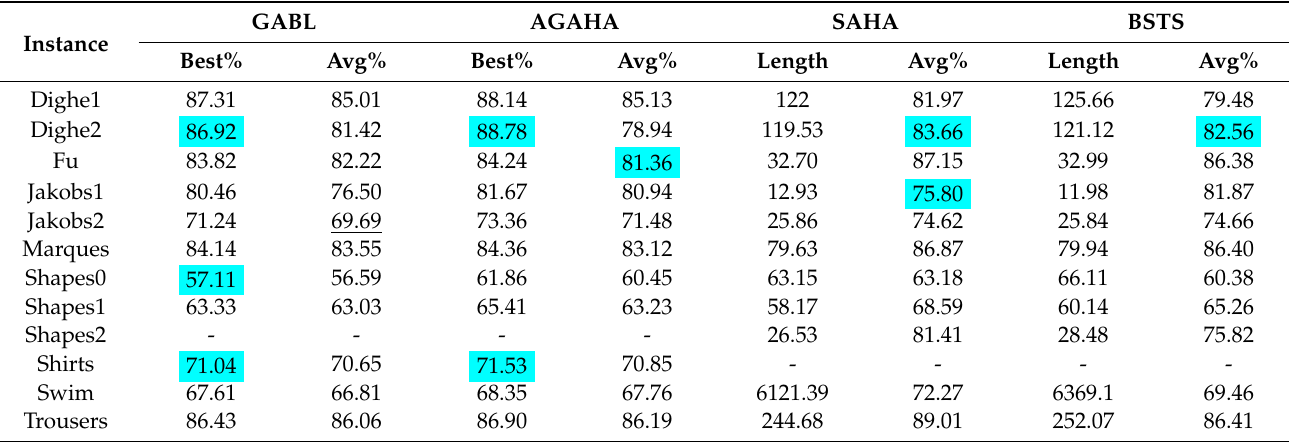
Table 3. Packing results in the corresponding